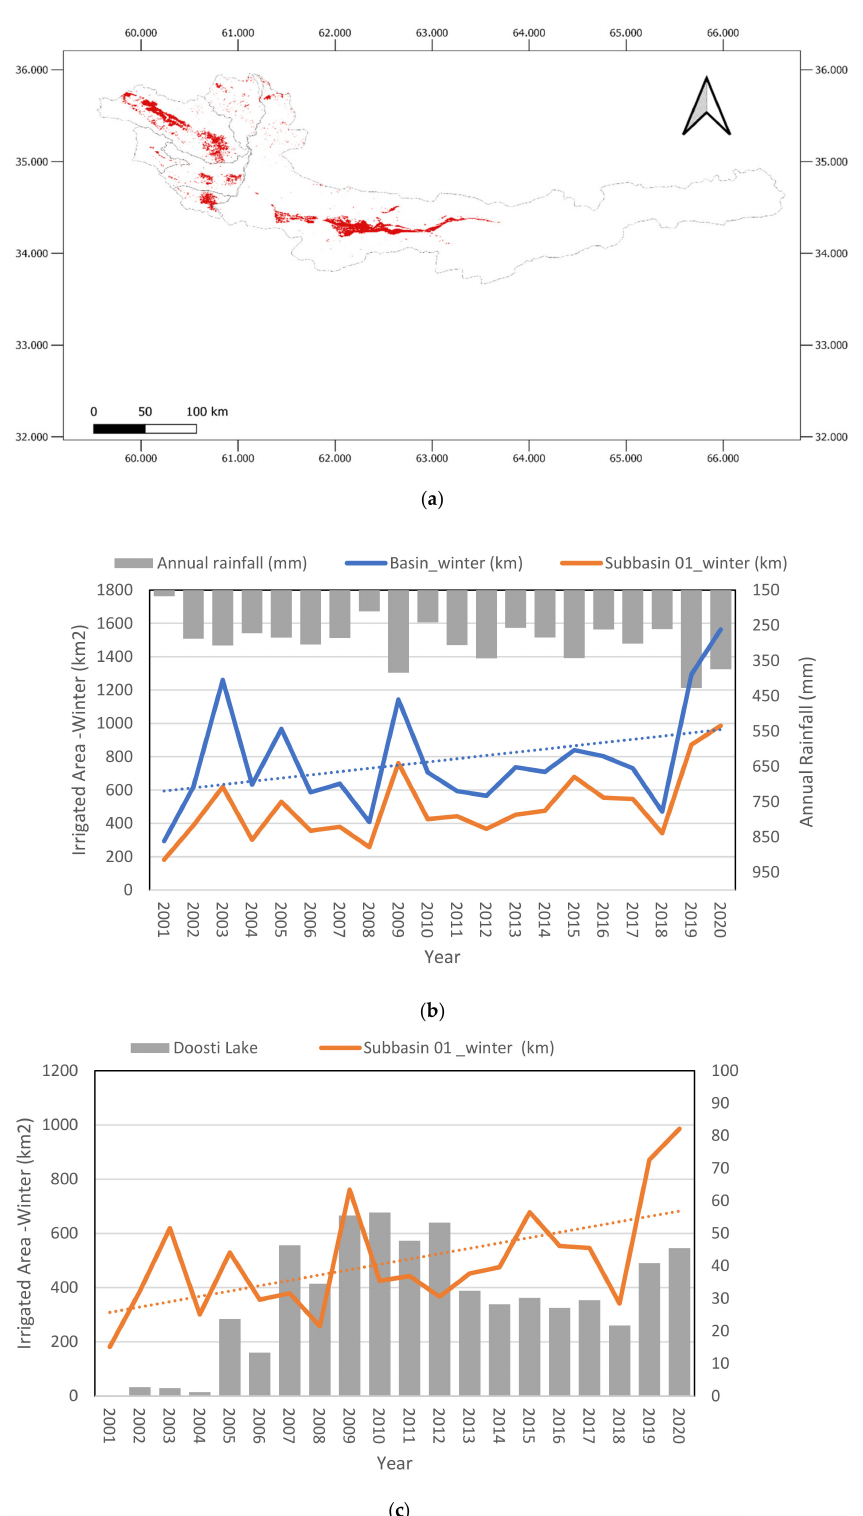
Figure 14. ( a ) Spatial distribution of irrigated cultivated lands in Doosti Dam’s basin as well as changes that occurred between 2001 and 2020, ( b ) correlation between rainfall (CHIRPS), irrigated cultivated areas of basin (km 2 ) in winter growing season based on the MODIS NDVI product (MOD09Q) derived from GEE during 2001–2020, ( c ) correlation between rainfall time series (CHIRPS), irrigated cultivated areas (km 2 ) of subbasin in winter growing season and Doosti lake based on Landsat, NDWI index product during